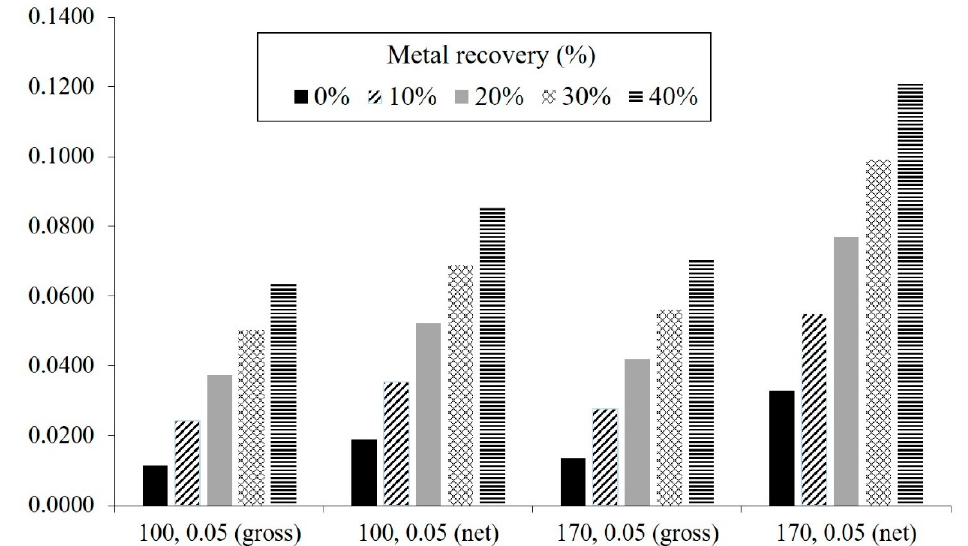
Figure 5. 3T values for CHP from the simulated landfill gas and different recovery percentage of metals.